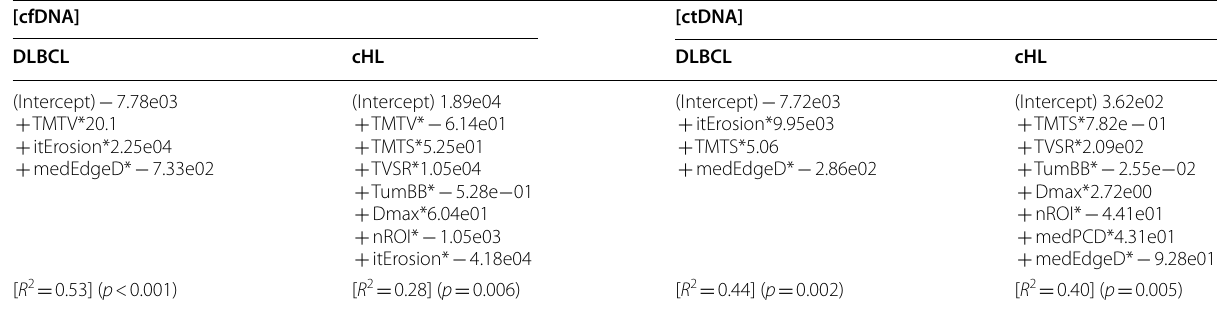
Table 3 Multivariate stepwise regression between twelve PET parameters (SUVmax, SUVmean, TMTV, TLG, TMTS, TVSR, TumBB, Dmax, nROI, itErosion, medPCD, medEdgeD) and two blood DNA parameters ([cfDNA], [ctDNA]) with